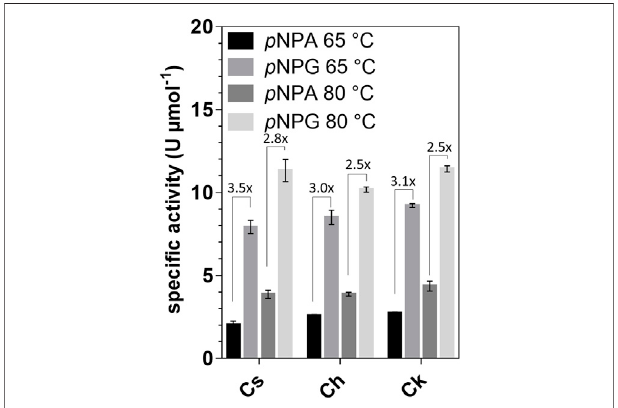
FIGURE 2 | Speci fi c activities of Cs _Gaf195A, Ch _Gaf159A and Ck _Gaf159A with p NPA and p NPG at 65 and 80 ° C. The p NPG-cleaving and p NPA-cleaving activities are indicated as fold changes. Standard reactions contained 0.1 µg μ l − 1 enzyme and were performed in triplicates and incubated for 20 min.